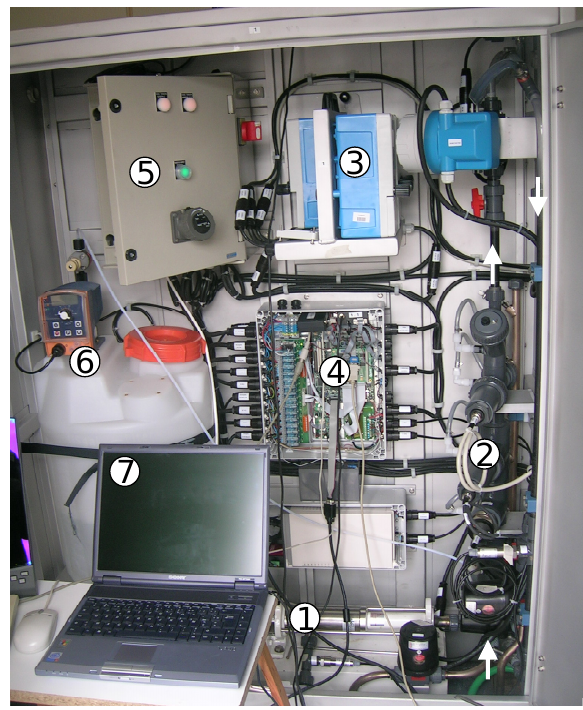
Fig. 2. Sketch of the MAGEST automated station showing the main parts of the measuring system: (1) the pump, (2) the measuring cell, (3) the transmission system, (4) measurement and control electronic system, (5) the electric power supply, and (6) the antifouling sys- tem. Arrows underline water circulation. Labtop (7) can be directly connected for on field maintenance. The dimensions of a station are roughly 0.8m in width, 1.8m in height, and 0.5m in